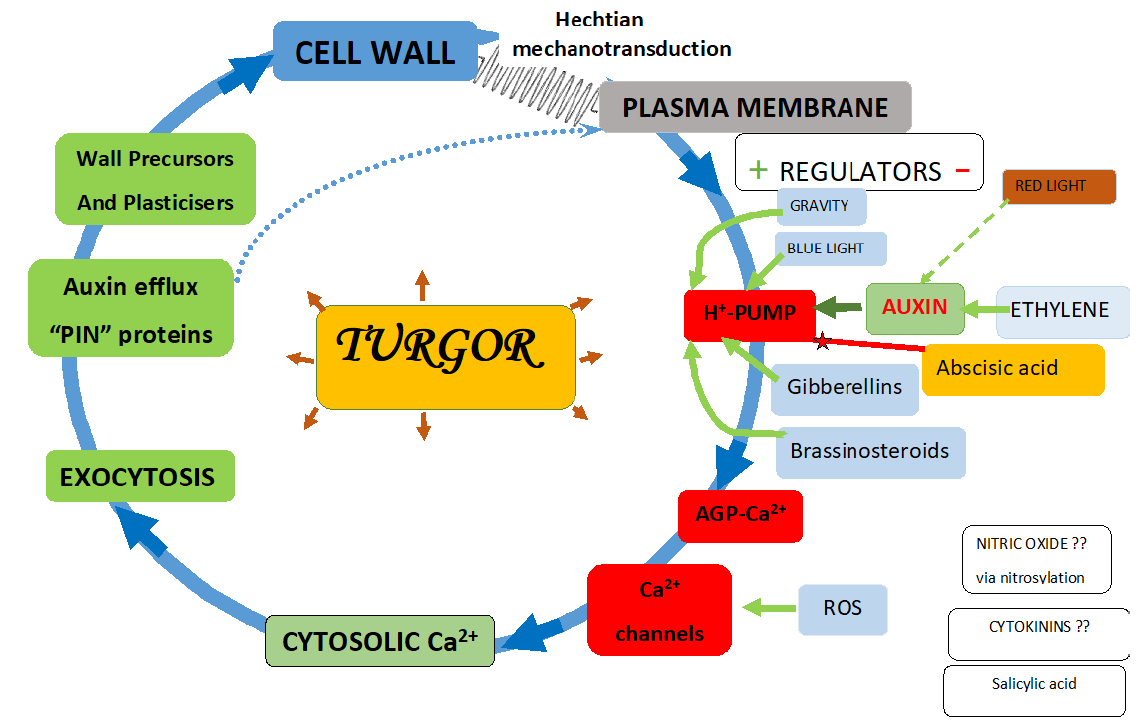
Figure 1. The Hechtian growth oscillator incorporates a molecular pinball machine. The ATPase proton pump generates proton “pinballs” that release Ca 2+ ions from AGP glycomodules, which supply cytosolic Ca 2+ . Turgor drives cell expansion and activates the pump by the mechanotransduction of wall stress via Hechtian adhesion between the plasma membrane and the cell wall; this creates a Hechtian oscillator that regulates cycles of cell wall plasticity and oscillatory growth. Auxin is the other major proton pump activator transported by auxin-efflux “PIN” proteins. ATPase proton pump regulation is central to plant growth and development [28]. The figure depicts numerous additional inputs. Green arrows indicate upregulation, and red represents downregulation, with exceptions where the mechanism remains unknown. Dotted blue arrows indicate PIN proteins that are directly incorporated into the plasma membrane as integral components. Numerous features underlie the reductionist simplicity shown in the above figure: high auxin levels generally enhance cell extension [29]; auxin-driven morphogenetic patterns depend on unidirectional fluxes [30]; the evolution of auxin signalling and PIN proteins [31]; auxin biosynthesis occurs in meristems [32]; auxin activates the plasma membrane H+-ATPase via phosphorylation [28]. Negative regulation by abscisic acid decreases steady-state levels of phosphorylated H + -ATPase, possibly by promoting dephosphorylation via a protein phosphatase [33], and in turn suppresses hypocotyl elongation in Arabidopsis [33]; abscisic acid stress signalling evolved in algal progenitors [34]. Blue light: the blue light photoreceptor pigment phototropin increases cytosolic Ca 2+ [35]. Brassinosteroids: increase cytosolic Ca 2+ via increased auxin levels [36]. Cytokinins enhance cell division by unknown mechanisms. Ethylene upregulates auxin biosynthesis in the Arabidopsis root apex and inhibits root cell expansion [37]; thus, anthranilate synthase mutants yield ethylene-insensitive root growth phenotypes. Ethylene specifically inhibits the most rapid growth phase of expanding cells—normally the root hair initiation zone—but ethylene moves it much closer to the tip. Auxin and ethylene act synergistically to control root elongation, root hair formation, lateral root formation and hypocotyl elongation. Ethylene modulates root elongation through altering auxin transport [38]. This figure is a revised version of Figure 2 in [39], animation at https://youtu.be/zABg7LiBk88 (accessed on 30 June